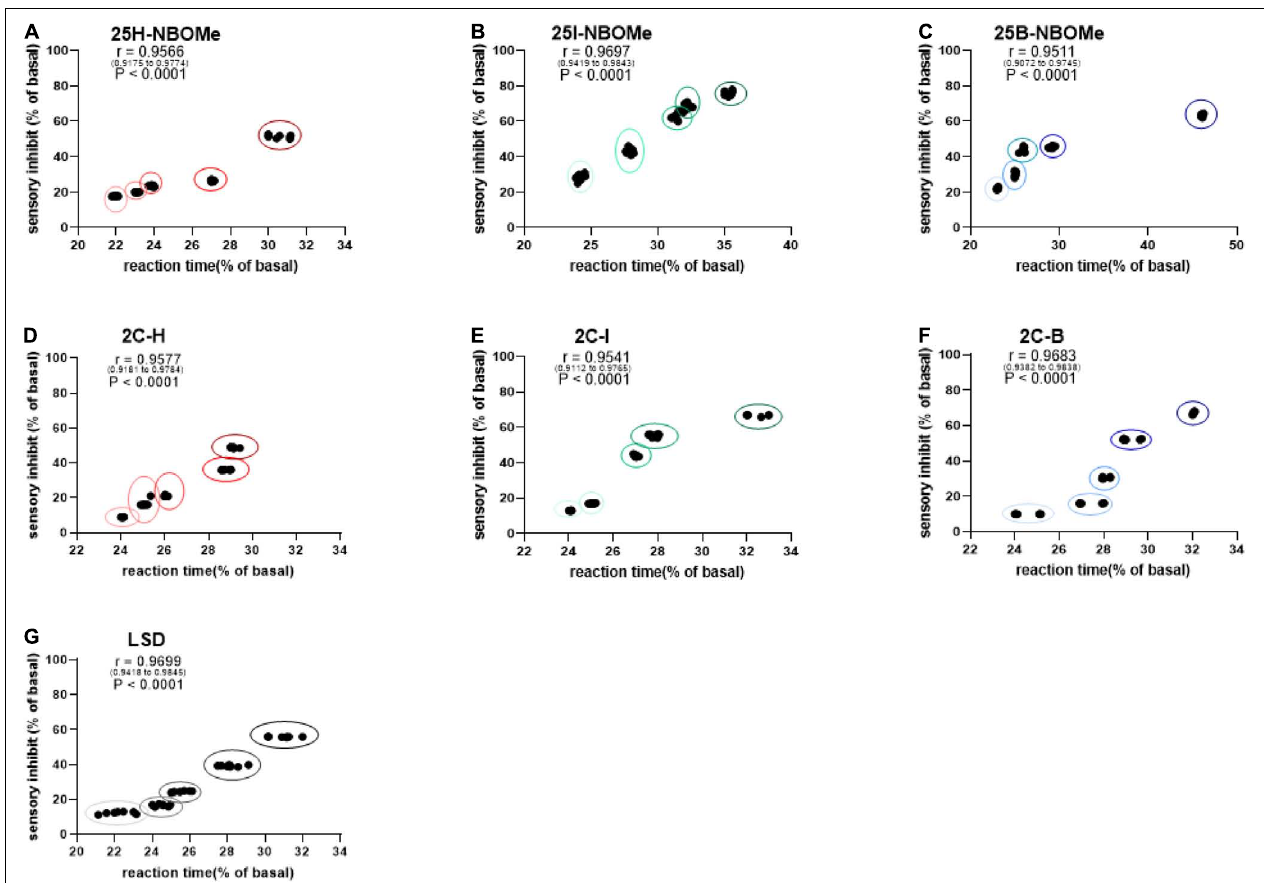
FIGURE 6 | Correlation between sensory dysperception and reaction time of mice following administration of 25H-NBOMe (0.001–10 mg/kg i.p.) (A) , 25I-NBOMe (0.001–10 mg/kg i.p.) (B) , 25B-NBOMe (0.001–10 mg/kg i.p.) (C) , 2C-H. (0001–10 mg/kg i.p.) (D) , 2C-I (0.001–10 mg/kg i.p.) (E) , 2C-B (0.001–10 mg/kg i.p.) (F) , and LSD (0.001–10 mg/kg i.p.) (G) observed in 1 h. Data are expressed as mean ± SEM ( n = 8/group). Statistical analysis was performed by XY correlation, which revealed a correlation between the two different effects of treatment. p <